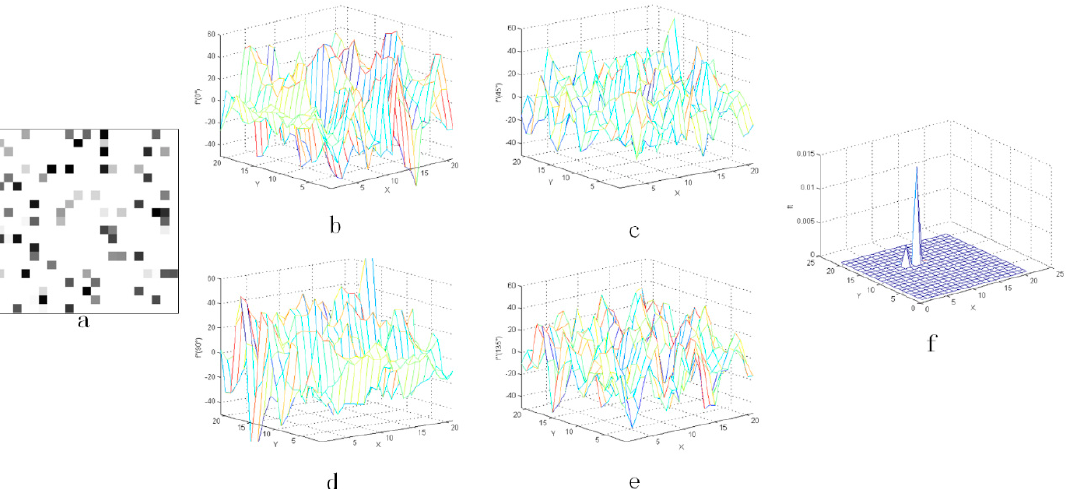
Figure 12. The result with the noise whose coefficient Q is 80%: ( a ) the star image with added random noise and ( b – e ) the three-dimensional distribution of the second-order derivative, ( f ) the output value f t after CMLCM processing.